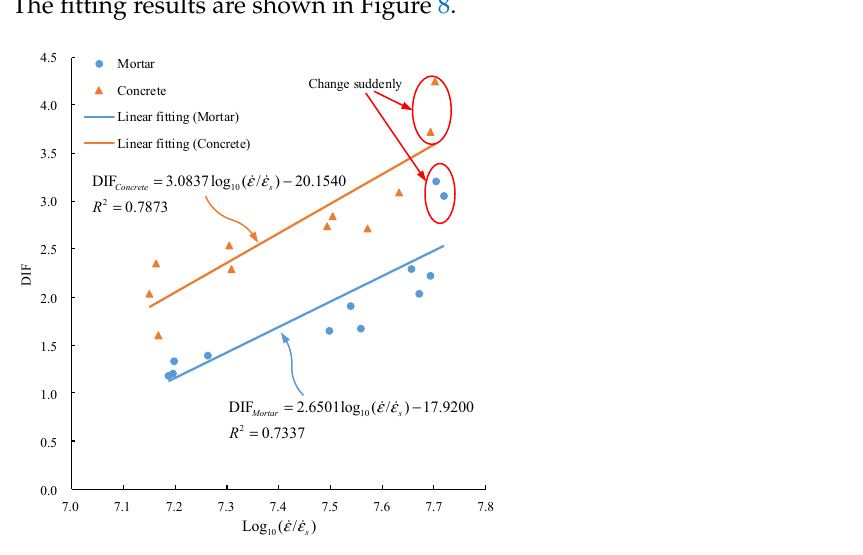
Figure 7. Strain rate time history curve: ( a ) Mortar , ( b ) Concrete.